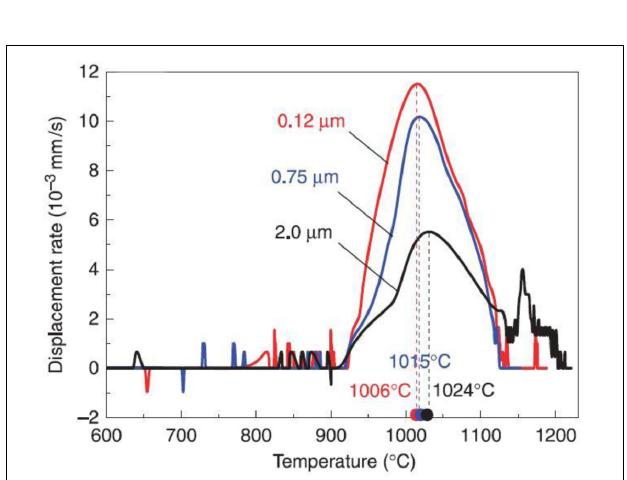
FIGURE 1 | Changes in the (A) hardness and (B) bending strength of cemented carbides with increasing proportion of coarse and fine grained WC (Akhtar et al., 2007) [Figure 3 of Akhtar et al. (2007), Copyright Elsevier Ltd].